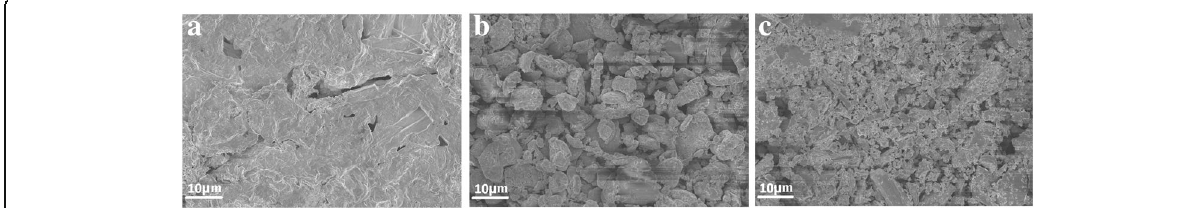
Fig. 3 SEM images of the powders produced by a anti-solvent, b milling, and c spray methods